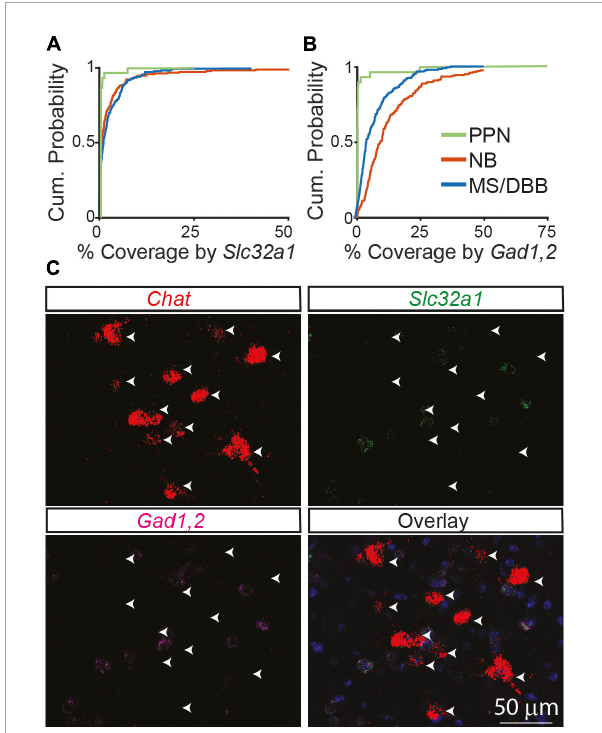
FIGURE3 GABAergic markers are not expressed in cholinergic neurons in the PPN of adult mice compared to the NB and MS/DBB. (A) Cumulative distribution of Chat ROI coverage in the PPN by Slc32a1 (A) and Gad1 ,2 (B) compared to neurons in the NB and MS/DBB. Data from PPN includes 188 Chat + cells from n = 3 mice, from NB includes 199 Chat + neurons from n = 5, and from MS/DBB includes 181 Chat + cells from n = 4 mice. (C) Example images of Chat, Slc32a1, and Gad1,2 in the pedunculopontine nucleus. Arrowheads indicate the position of Chat + neurons across the